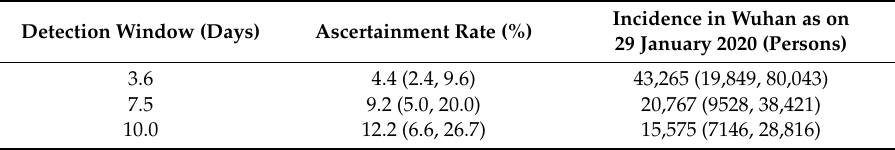
Table 1. Exportation events and estimated incidence in